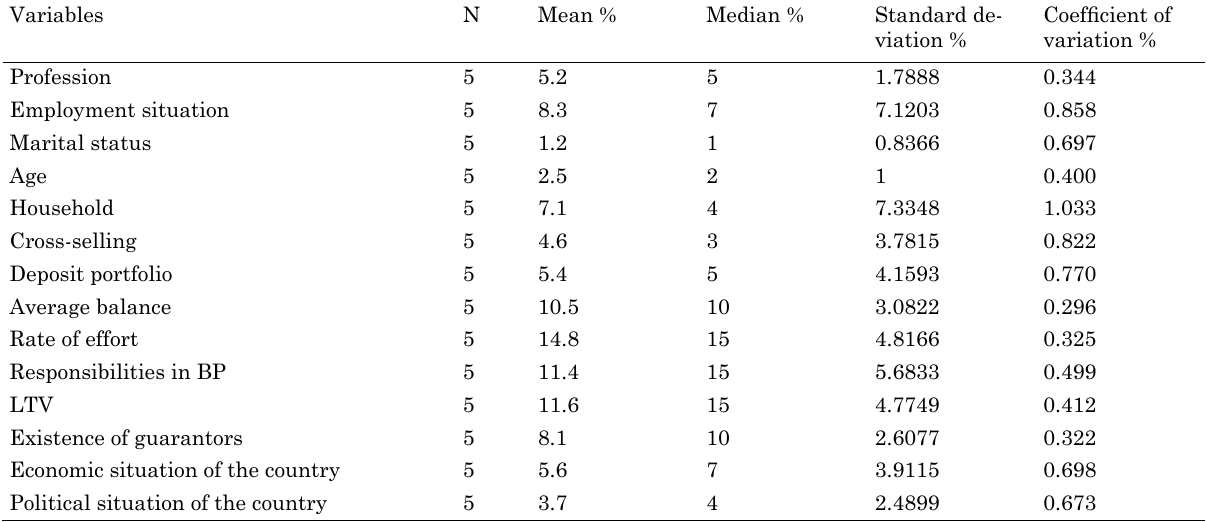
Table 2. Statistics of the second round